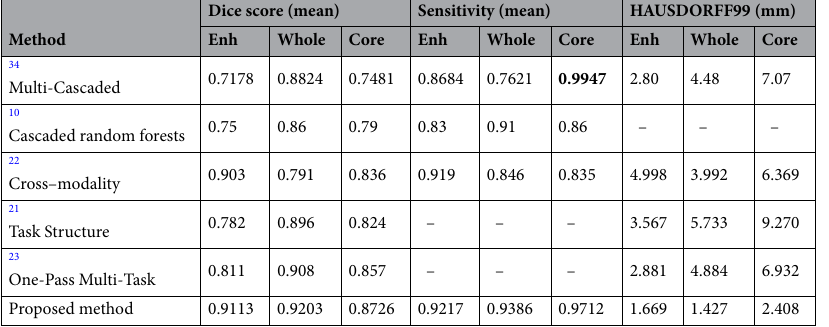
Table 2. Comparison between the proposed method and other baseline approaches on BRATS 2018 dataset.